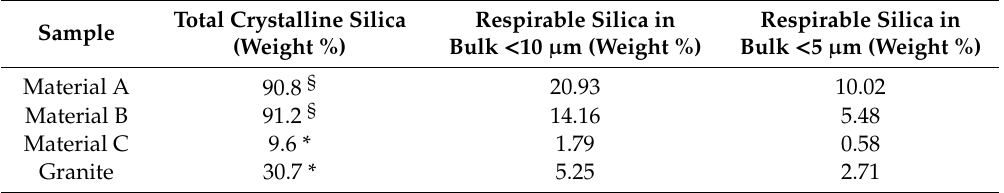
Table 4. Total and respirable crystalline silica in bulk debris